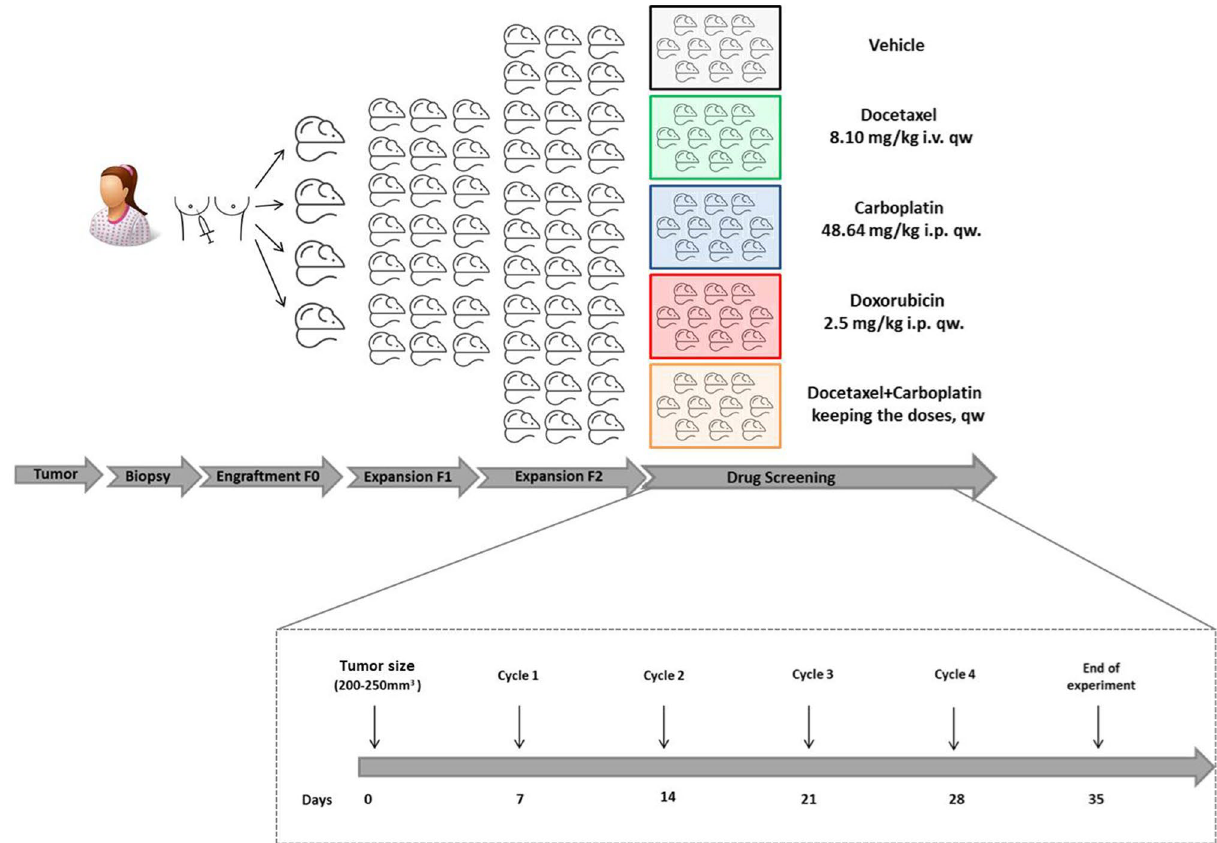
Figure 4. Experimental design of the trial. F0, first engraftment; F1, expansion cohort; F2, treatment